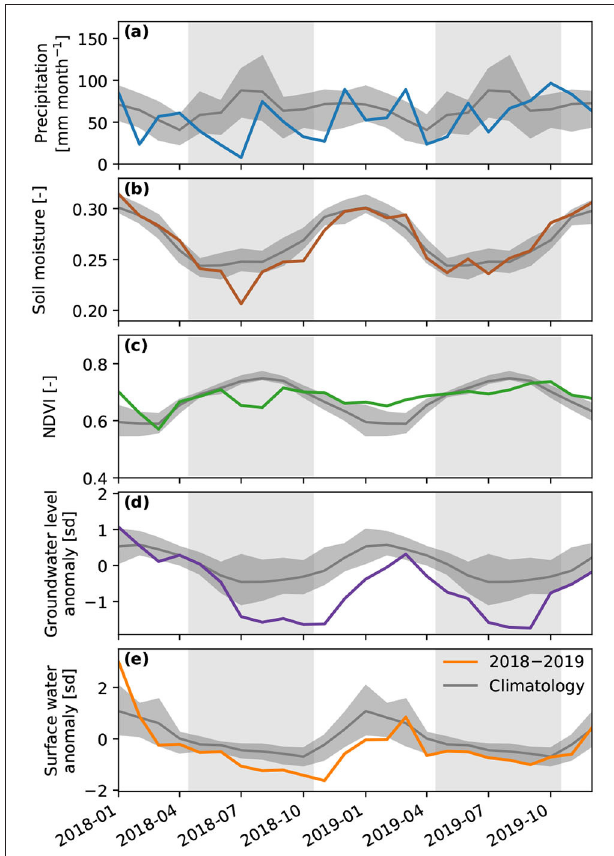
FIGURE 3 | Temporal evolution of the drought over 2018-2019 for the different variables. The gray line shows the monthly mean over the entire period, where the colored line represents the mean time series for 2018 and 2019. The gray shaded area shows the monthly temporal variability, using the 20-80% quantile range. Precipitation, soil moisture and NDVI (A-C) are shown as their observed values. Groundwater and surface water levels (D,E) are normalized using the mean and standard deviations of each station. The two highlighted areas indicate the periods used in Figure 4